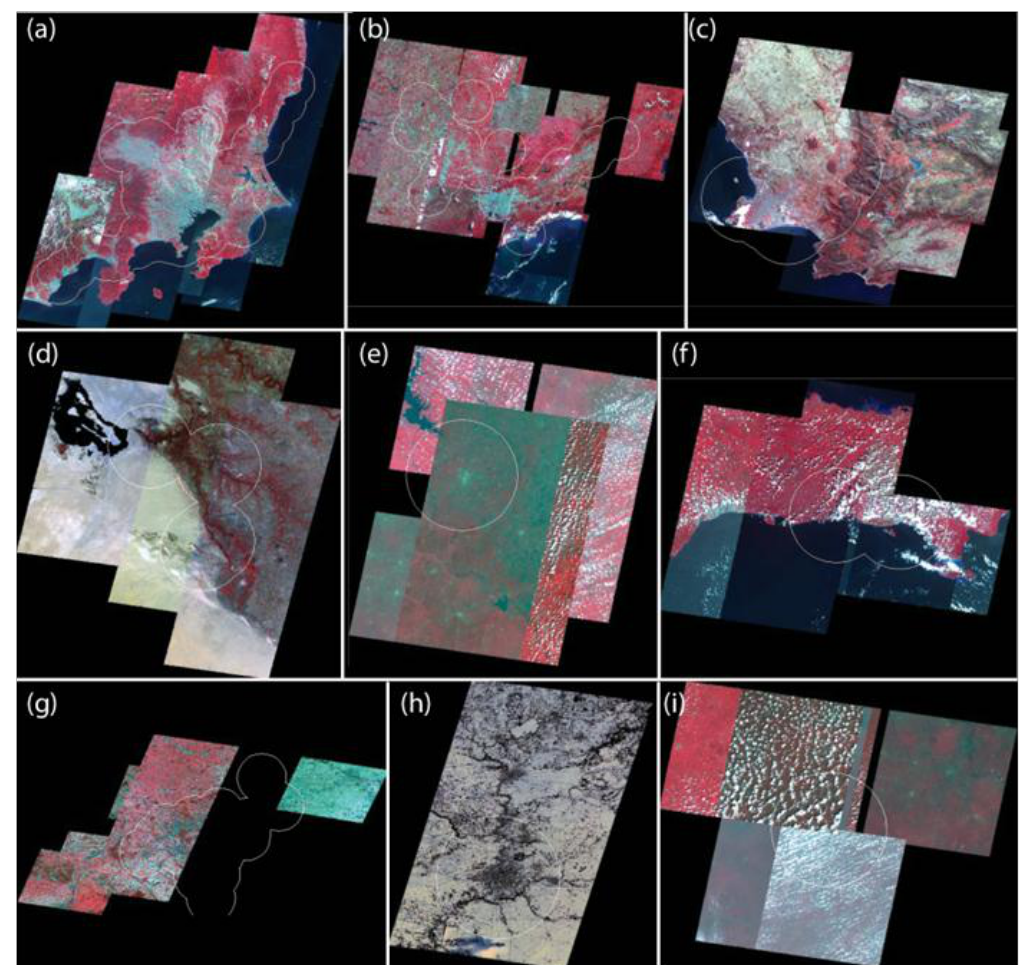
Figure 2. Examples of the results of automated selecting the ASTER/VNIR images. The background images are false color composite of the merged ASTER/VNIR. The white lines represents the boundary of the crowd of cities. (a) Tokyo (Japan), (b) Sao Paulo (Brazil), (c) Cape Town (South Africa), (d) Najaf (Iraq), (e) Yamoussoukro (Republic of Cote d'Ivoire), (f) La Romana (Dominican Republic), (g) Koln (Germany), (h) Rockford (United States of America), (i) Gagnoa (Republic of Cote